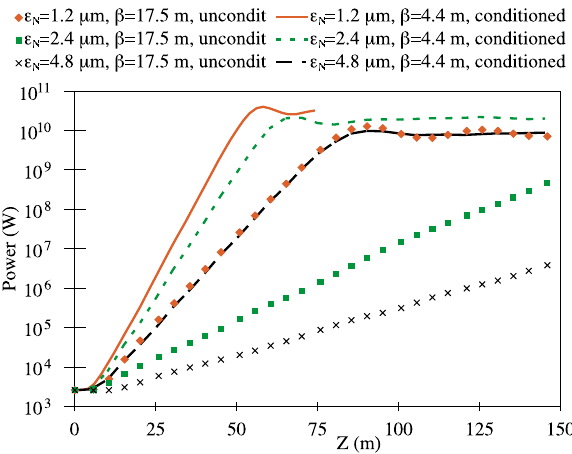
FIG. 4. (Color) Radiation power as a function of undulator length for LCLS, with different values of beam emittance, beta function, and for conditioned and unconditioned beams. Note that a conditioned beam with 4 times larger emittance (black line) achieves the same performance as the nominal case (red diamonds).